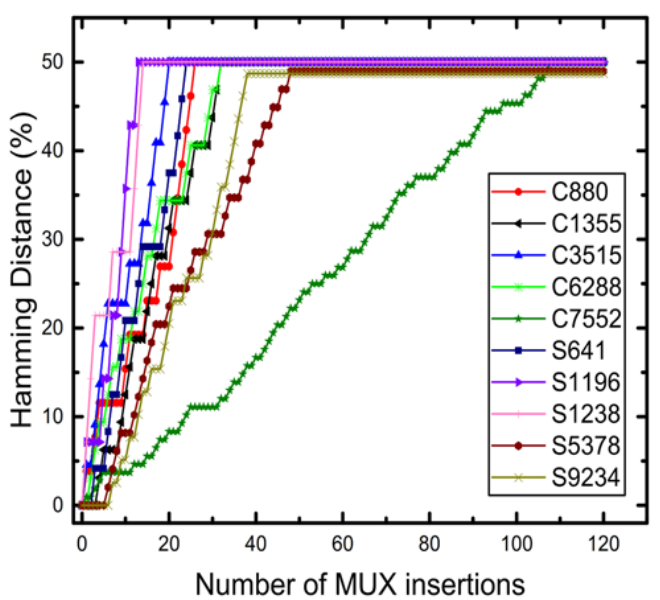
Figure 36. MUX insertions based on the full output number for different ISCAS ‘85 and ‘89 benchmark circuits.